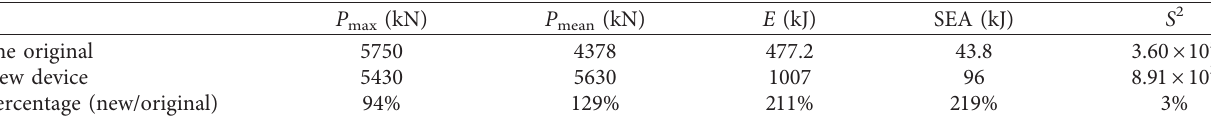
Table 4: Comparison of the energy absorption effect of original and new energy absorption